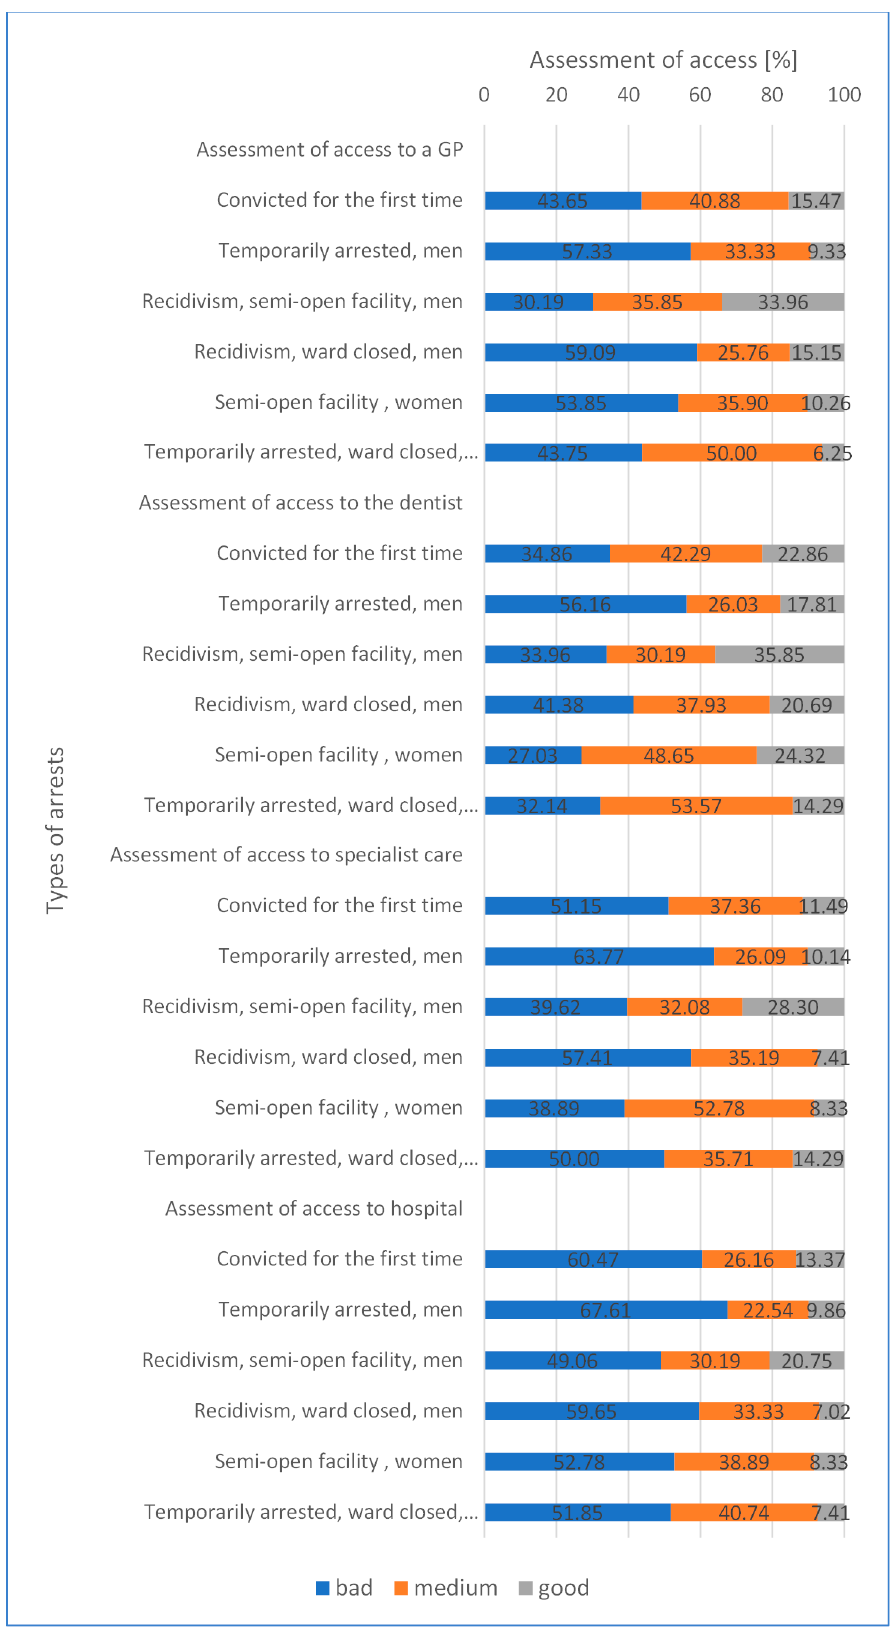
Figure 1. Subjective assessment of access to healthcare among prisoners (“bad”, “medium”, “good”) (test Chi-square).